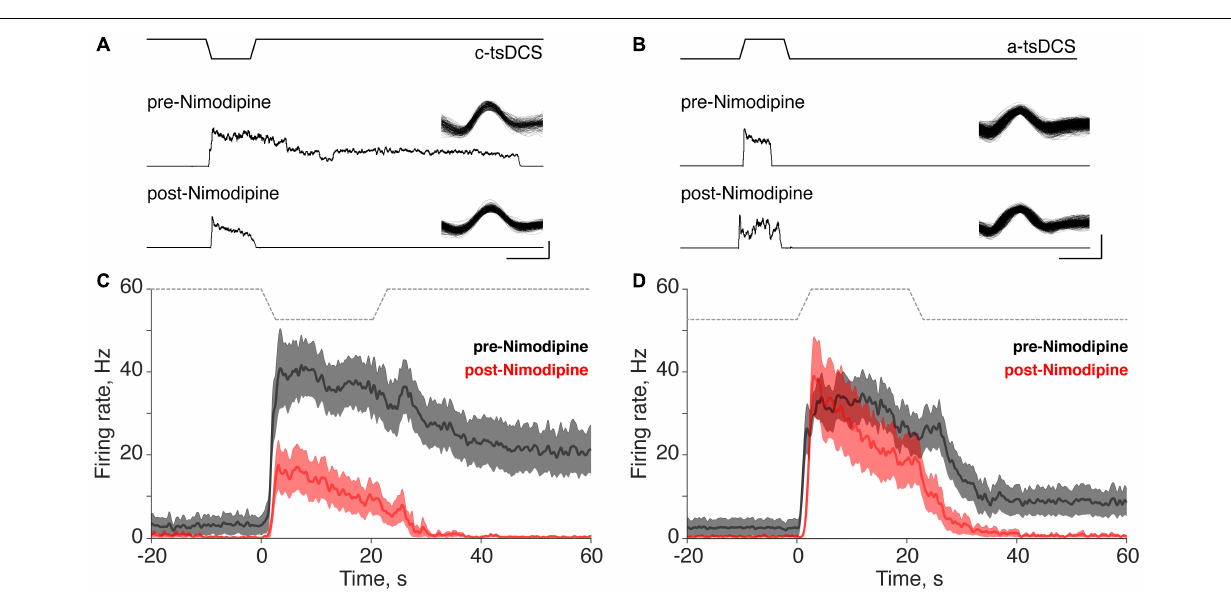
( t -test, p < 0.05; Figure 5A , inset). The effect of calcium channel mean firing rate of the direct response ( Figure 5B ). The larger the (slope: − 0.70, R-sq: 0.59; p < 0.05) and a-tsDCS (slope: − 0.62, R-sq 0.20; p <